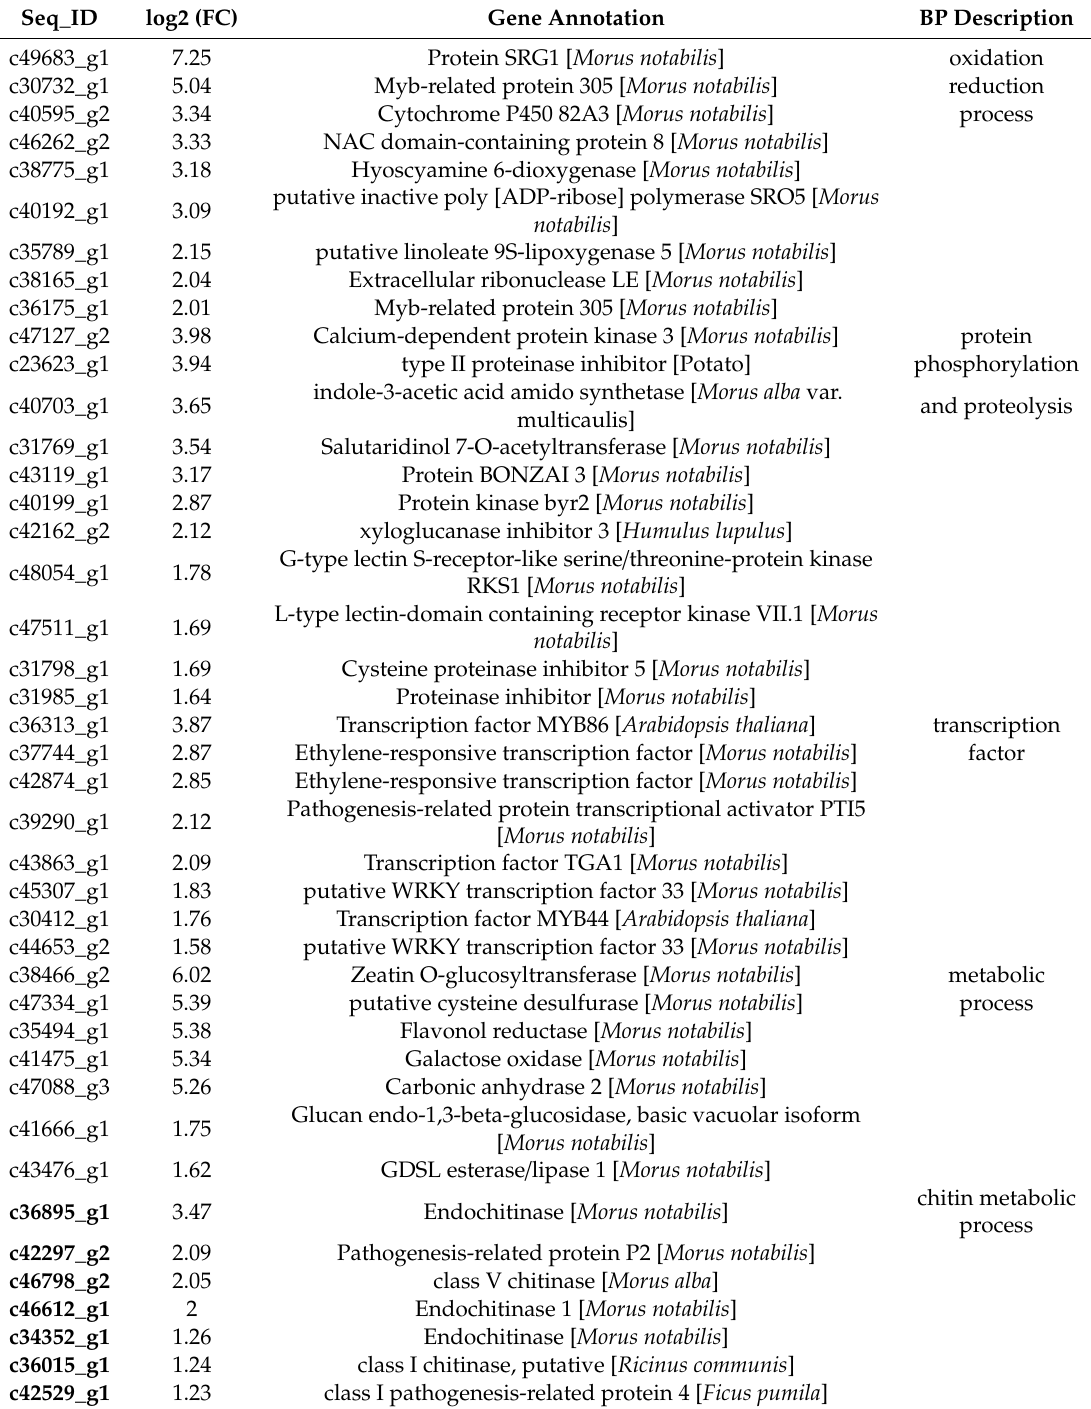
Table 2. The 42 candidate genes that were screened from the di ff erentially expressed